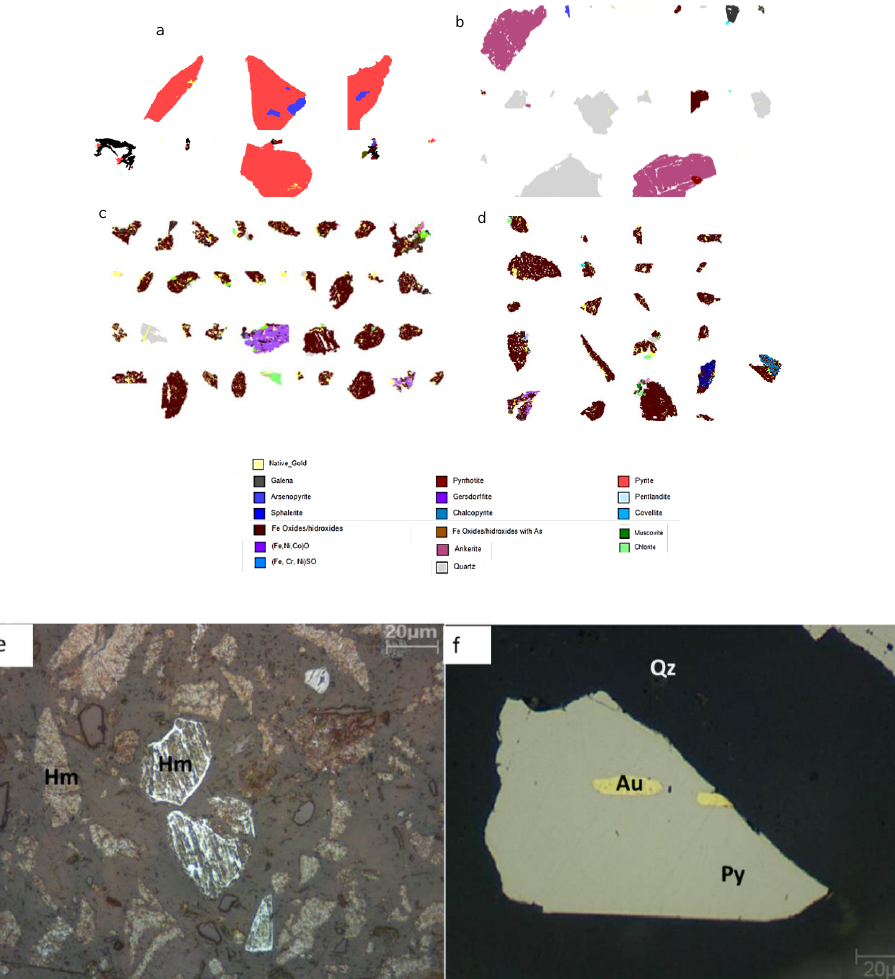
Figure 6. False Images ( a ) sulfides associated with iron oxide and Au particles—CoT, ( b ) quartz, carbonates and Fe oxides particles—CoT, ( c , d ) Fe oxides associated with Au, silicates and Fe oxides with As, Ni, Co, Al, Zn, Pb—CaT samples. Photomicrographs taken under reflected light and uncrossed nico ( e ) hematite (Ht) from CaT samples and ( f ) Au associated with pyrite (Py)—CoT samples.